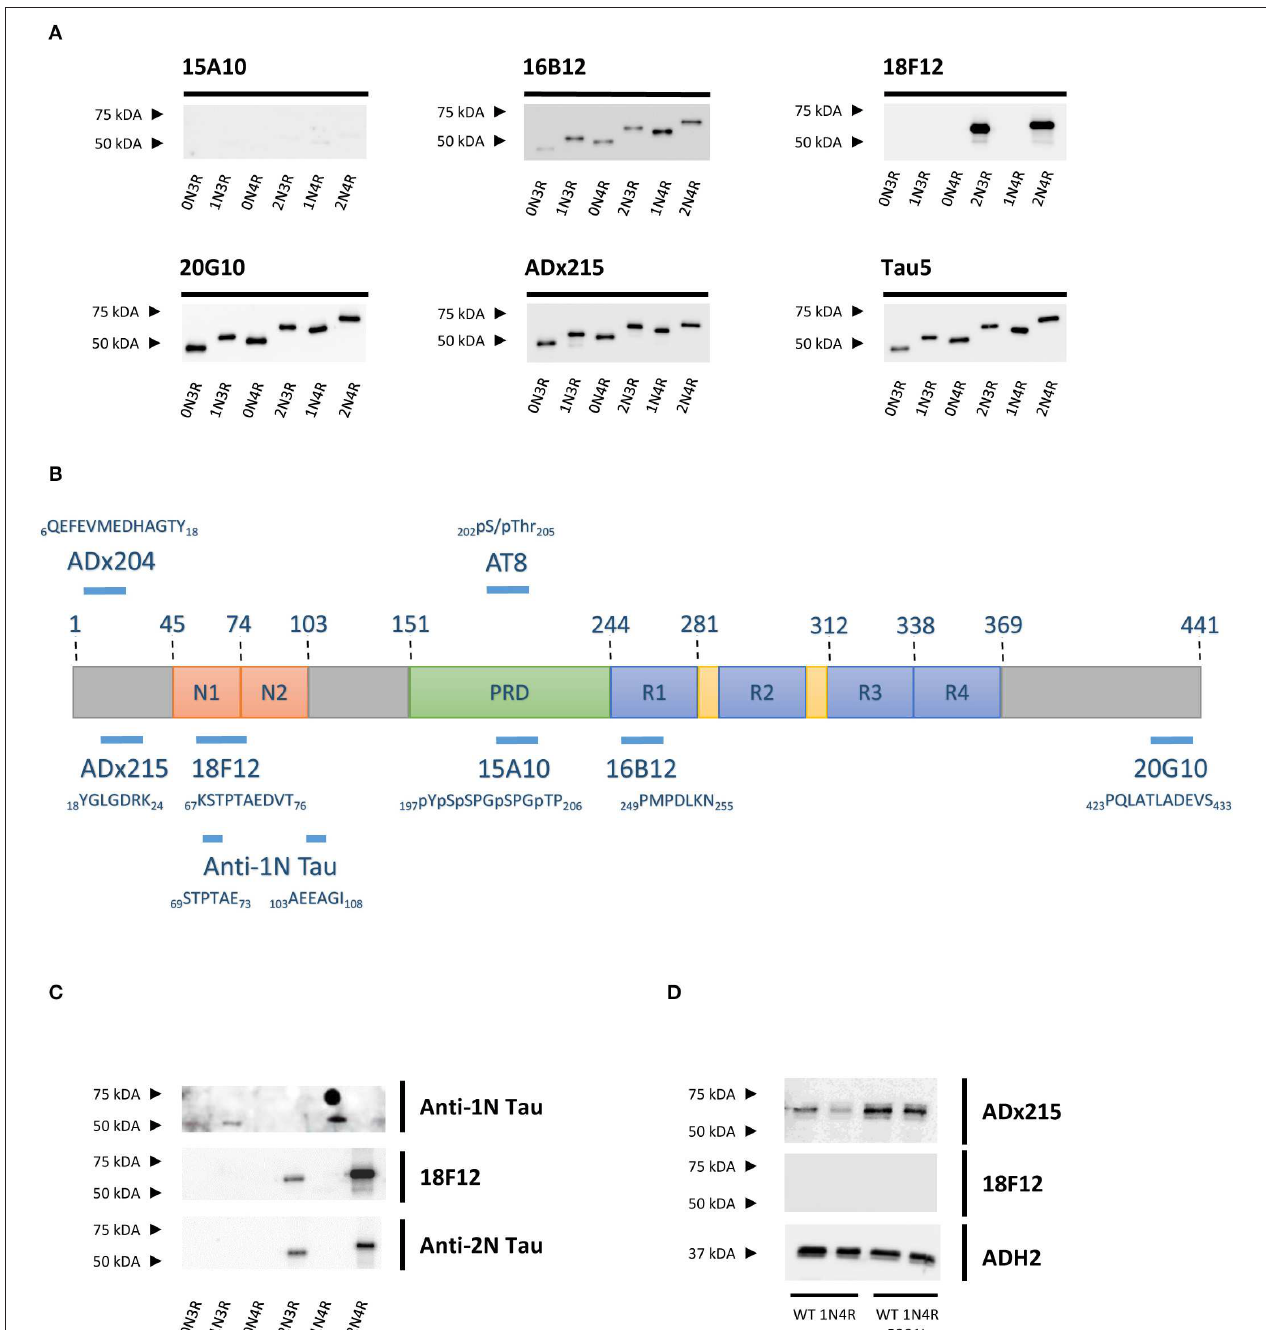
FIGURE 2 | Characterization of the novel mAbs in E. coli and in yeast. (A) Western blot analysis of different bacterial recombinant proteins representing the six different splicing isoforms of Tau. Lane 1, human WT Tau0N3R, lane 2, human WT Tau1N3R, lane 3, human WT Tau0N4R, lane 4, human WT Tau2N3R, lane 5, human WT Tau1N4R, lane 6, human WT Tau2N4R. (B) Visual presentation of some of the used primary antibodies with their epitopes on full-length human Tau2N4R. (C) Western blot analysis of different bacterial recombinant proteins representing the six different splicing isoforms of Tau for comparison of 18F12 with an anti-1N Tau and an anti-2N Tau antibody. Lane 1, human WT Tau0N3R, lane 2, human WT Tau1N3R, lane 3, human WT Tau0N4R, lane 4, human WT Tau2N3R, lane 5, human WT Tau1N4R, lane 6, human WT Tau2N4R. (D) Western blot analysis of total protein extracts from WT BY4741 yeast strain expressing either WT human Tau1N4R or Tau1N4R-P301L using 18F12, ADx215, and ADH2 as a control. Lane 1–2 , human WT Tau1N4R, lane 3–4 , human Tau1N4R-P301L.